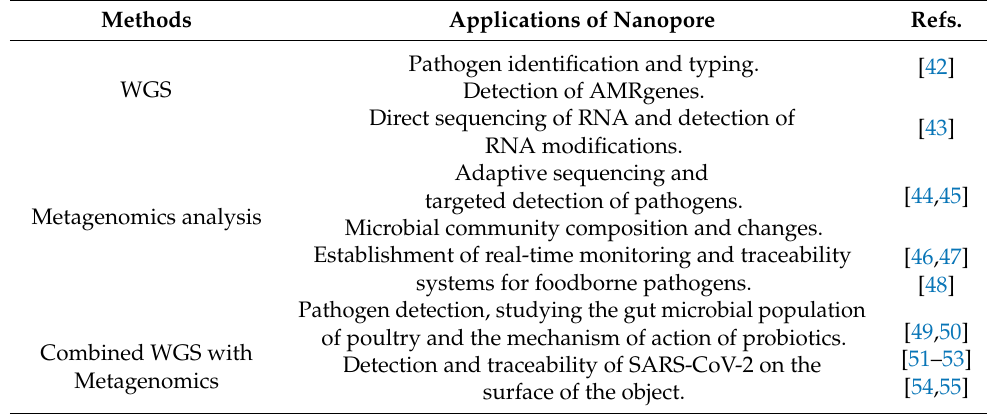
Table 2. Application of nanopore sequencing in foodborne diseases.